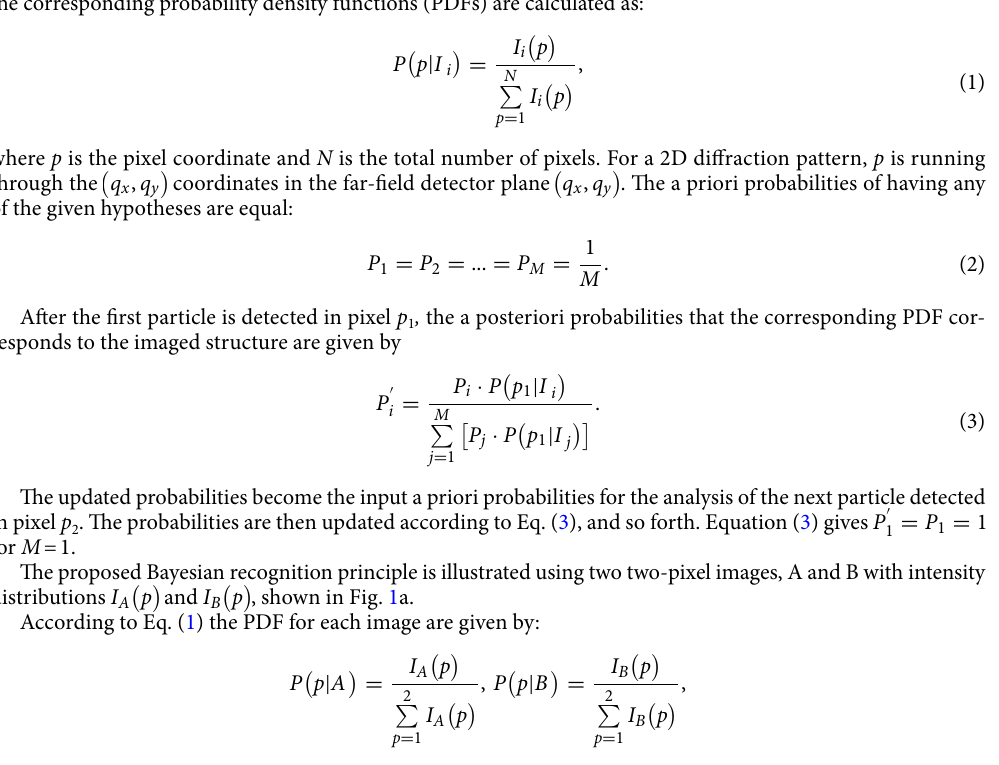
structural hypothesis of a single macromolecule’s orientation from its diffraction pattern. It is shown that already a few detected particles are sufficient to confirm a structural hypothesis at a high probability exceeding 95%. Principle Low‑dose recognition imaging. For M object hypotheses, M corresponding images I i are given and the corresponding probability density functions (PDFs) are calculated as: